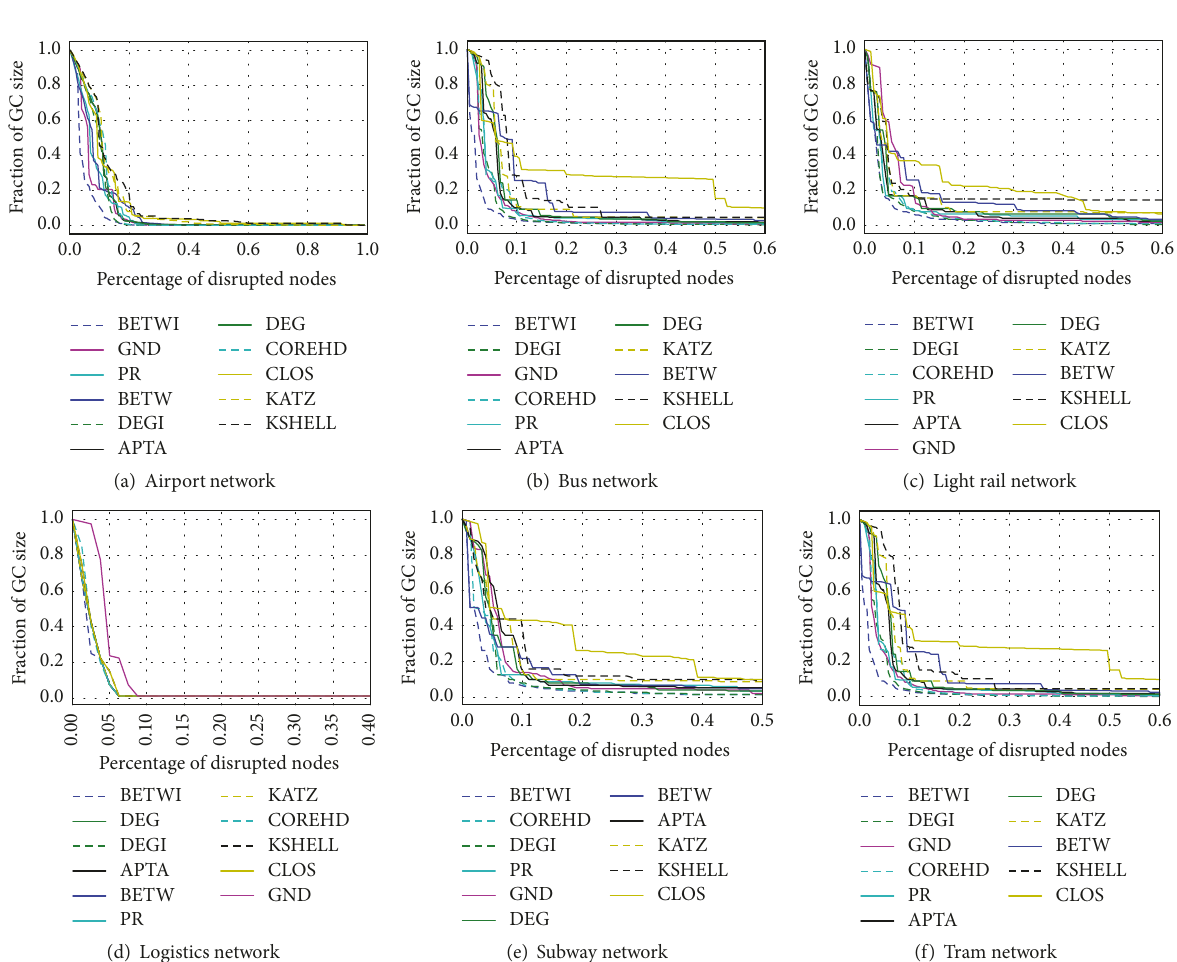
scale-free structure has proved to be robust to random failure but vulnerable to targeted attack ” [94]. “ This study indicates that the subway network is robust against random attacks but fragile for malicious attacks ”